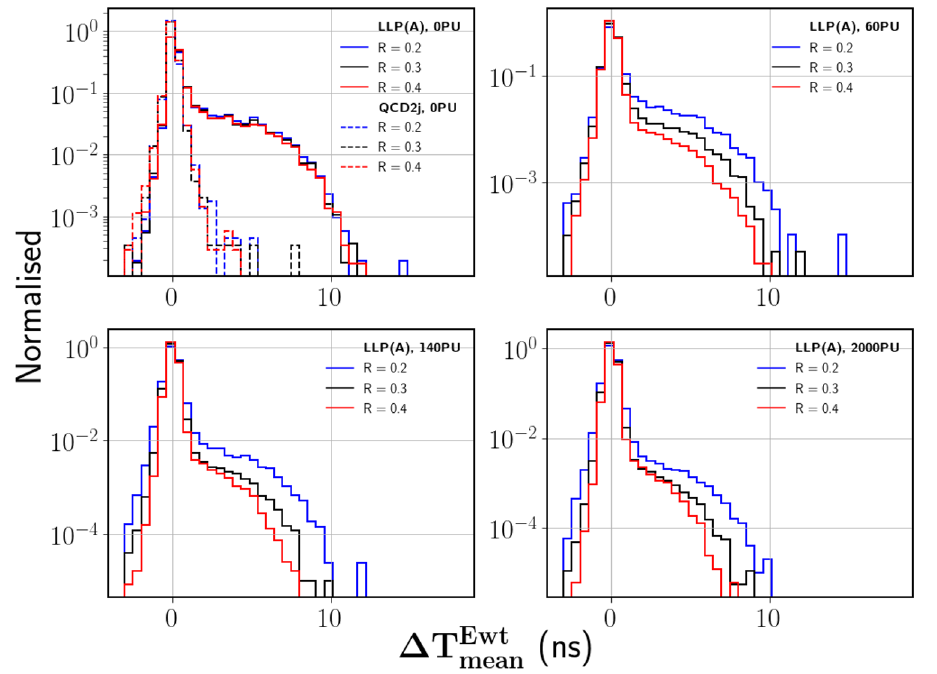
) with jet cone radius R = 0.2, 0.3, and 0.4 for LLP Figure 3 . The timing of the jets ( ∆ T Ewt mean scenario (A) with benchmark point ( M = 30 GeV, cτ = 100 cm) as well as QCD dijet events X ( p gen ∈ { 30 , 50 } GeV) for 0 PU ( top left ) and LLP scenario (A) with benchmark point ( M X = 30 GeV, T cτ = 100 cm) for 60 PU ( top right ), 140 PU ( bottom left ), and 200 PU ( bottom right